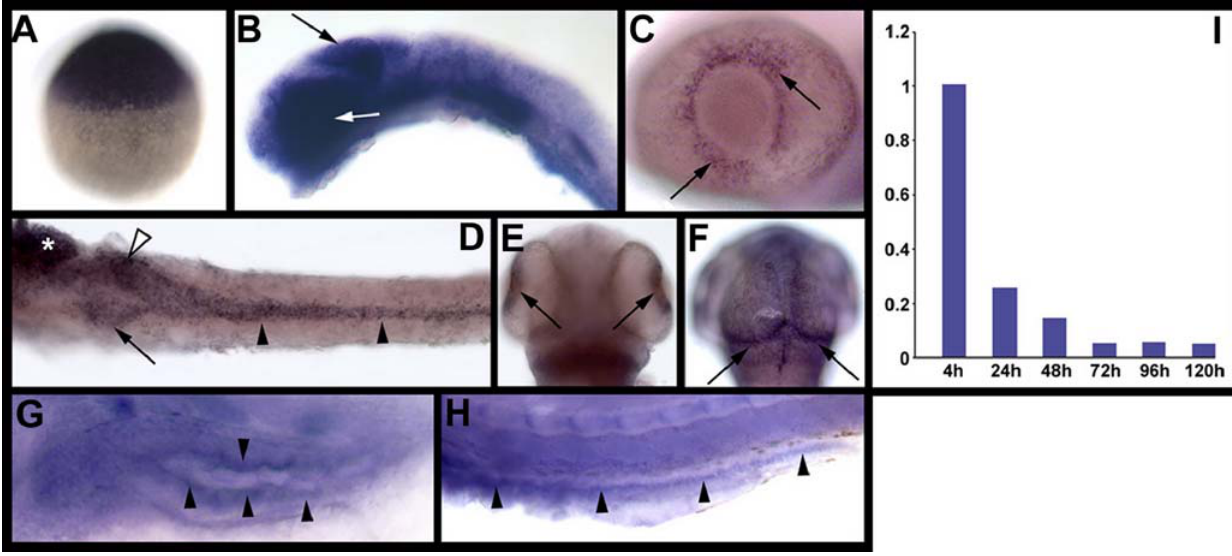
Figure 3. elys expression in developing zebrafish . Images (A–H) are whole mount RNA in situ hybridizations. (A) Maternal elys expression at 3 hpf. (B) Strong elys expression is evident in the midbrain (black arrow) and eye (white arrow) at 24 hpf. (C–F) Expression at 48 hpf in the retina (C,E), growth plate of the optic tectum (F), and digestive organs [(D): pancreas (arrow), anterior intestine (white arrowhead), posterior intestine (black arrowheads), liver (*)]. (G–H) Weak elys expression in the 5 dpf anterior (G) and posterior (H) intestine. (I) Graph showing elys expression in whole embryos (4 hpf–120 hpf) as determined via real-time quantitative PCR.